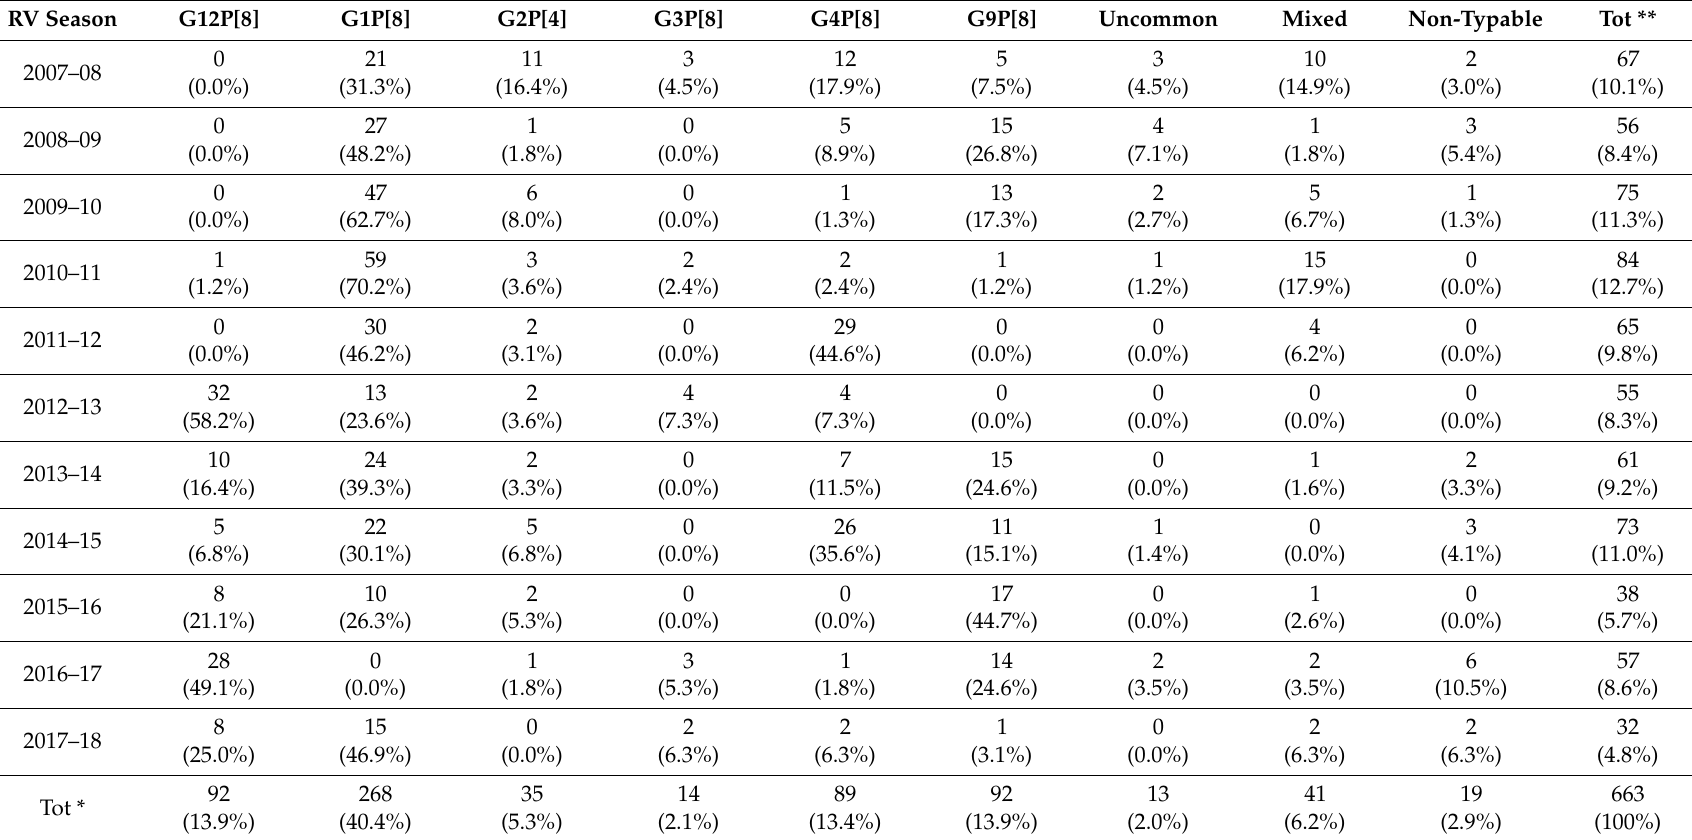
Table 2. Absolute and relative frequencies of detected RV genotypes stratified by surveillance